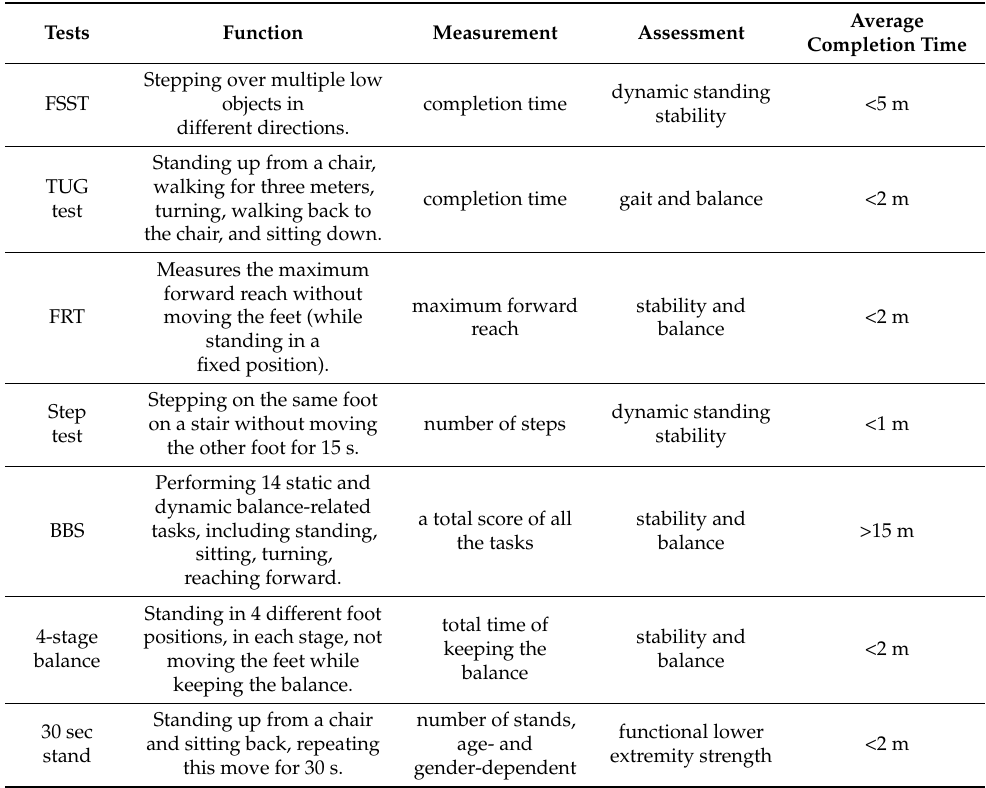
Table A1. An overview of fall-risk assessment clinical